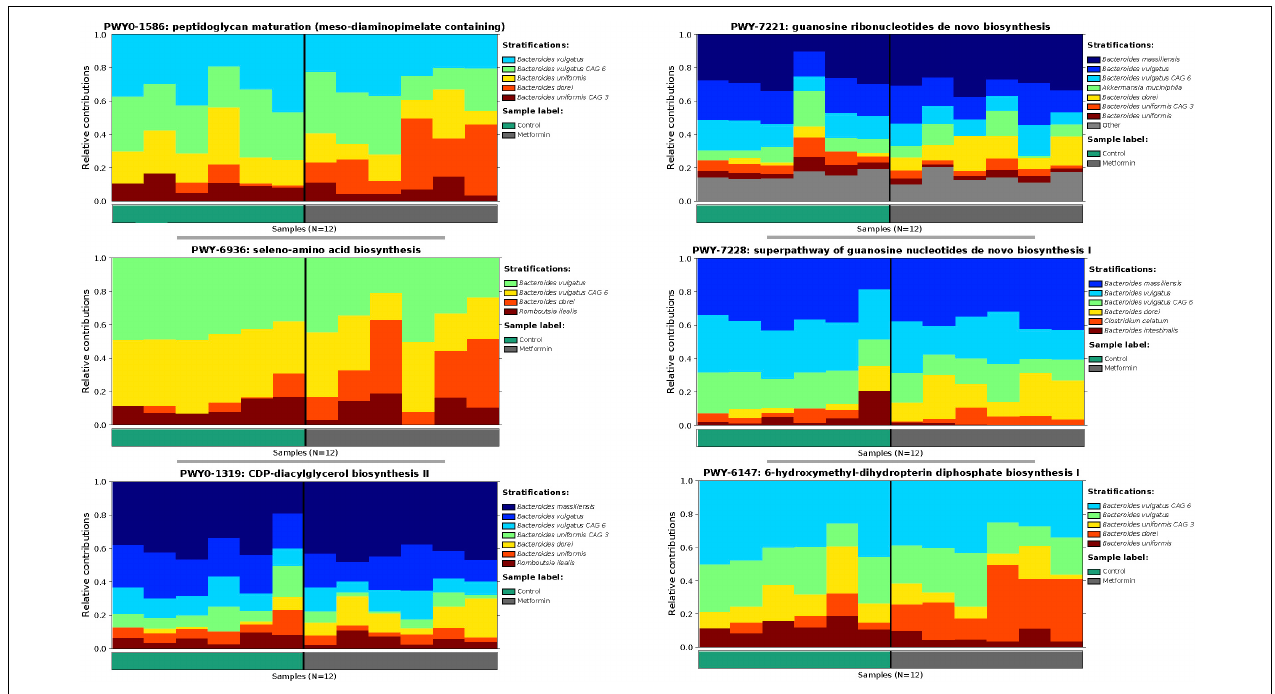
FIGURE 5 | Differential contributional pathway diversity of top-ranked pathways, determined by DEICODE and qurro from HUMAnN analysis.